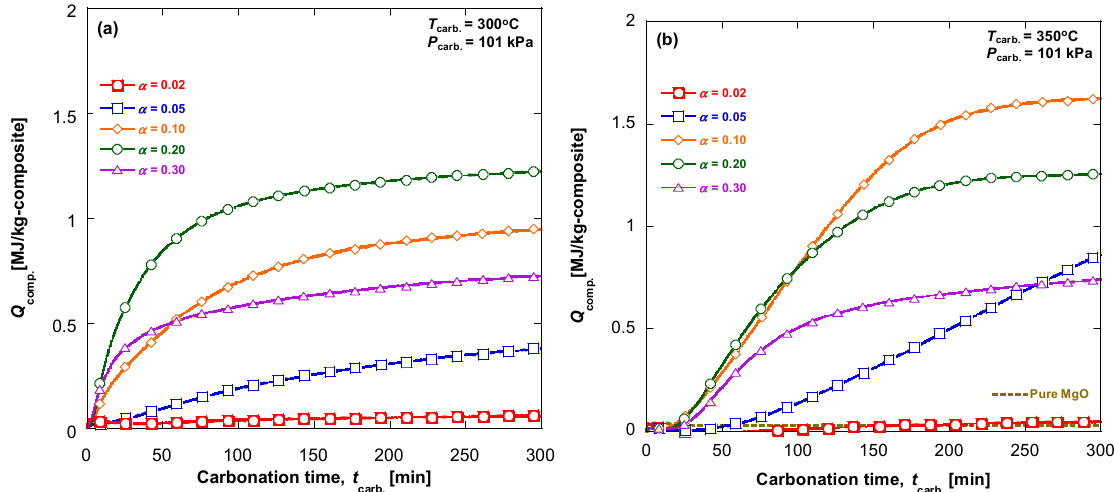
Figure 8. Specific useful heat, Q comp. , as a function of the carbonation time at ( a ) 300 °C and ( b ) 350 °C calculated from Figure 3.